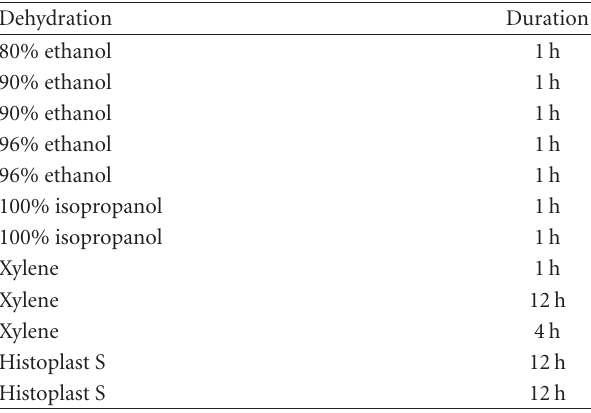
Table 1: Details of dehydration and embedding of zebrafish